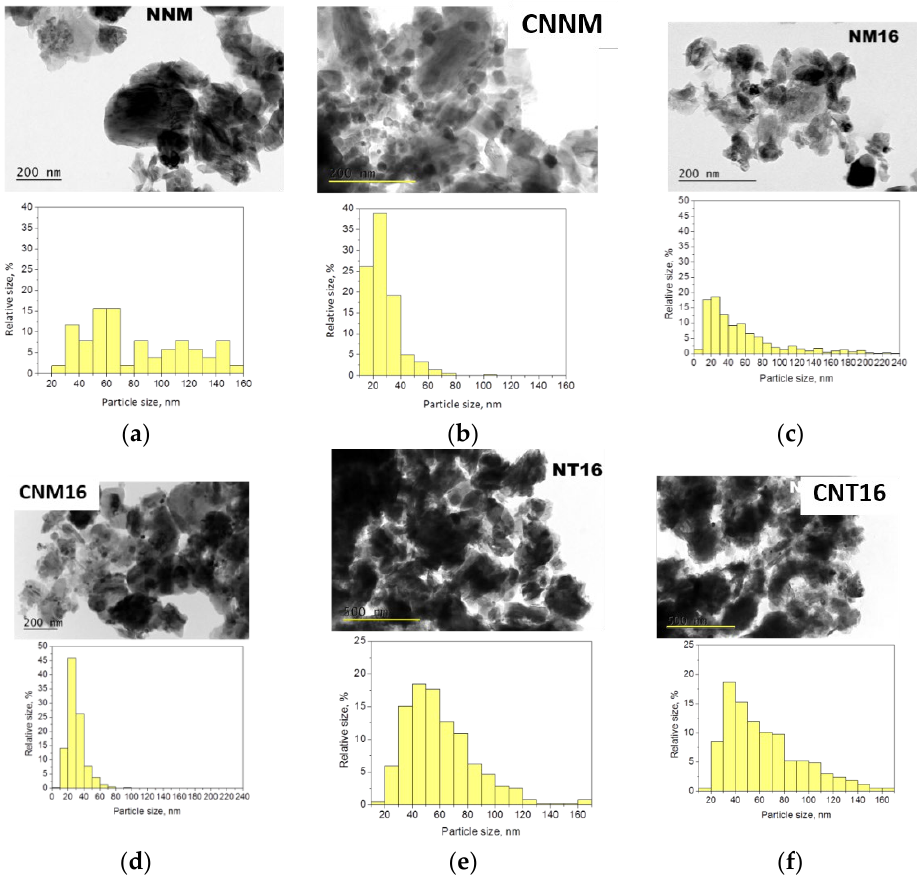
Figure 2. Bright-field TEM images and corresponding particle size–distribution curves for NNM, NM16, NT16 ( a–c ) and their CeO 2 -treated analogues (CNNM, CNM16 and CNT16) ( d–f ). Irrespective of the treatment type, the HR-TEM images display that, for all the samples, primary nanoparticles retain their good crystallinity (Figure 3). When layered oxides are modified with CeO 2 , lattice fringes are observed due to two phases. This means that, in modified oxides, there is intimate contact between particles of the two phases, which is developed at a nano-scale range (Figure